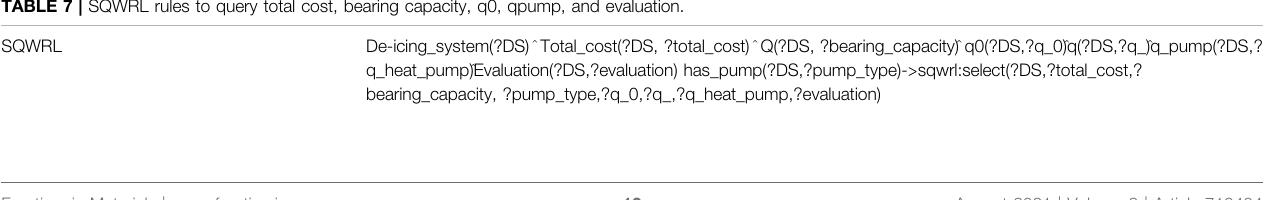
TABLE 7 | SQWRL rules to query total cost, bearing capacity, q0, qpump, and